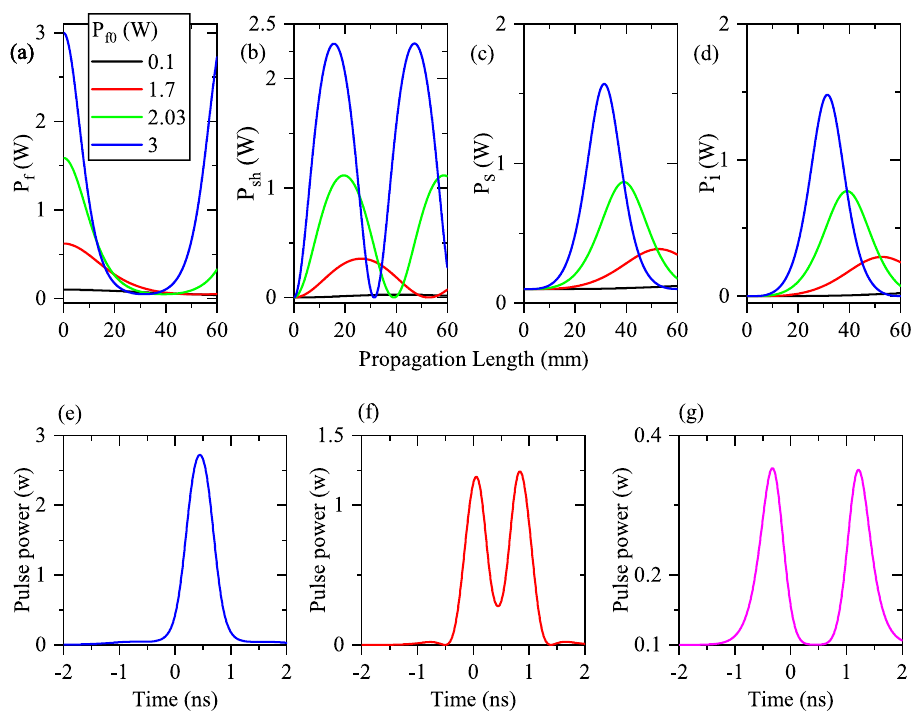
Figure 6. Propagation of different components of fundamental ( a ), generated SH ( b ), signal ( c ), and idler ( d ) modes with different values of P f 0 = 0.1, 1.7, 2.03, 3.00 W in a 60 mm long PPLN waveguide for the CW-cSHG/DFG process when �β = 0 (homogeneous waveguide). The out-coupled fundamental ( e ), generated SH ( f ), and signal ( g )